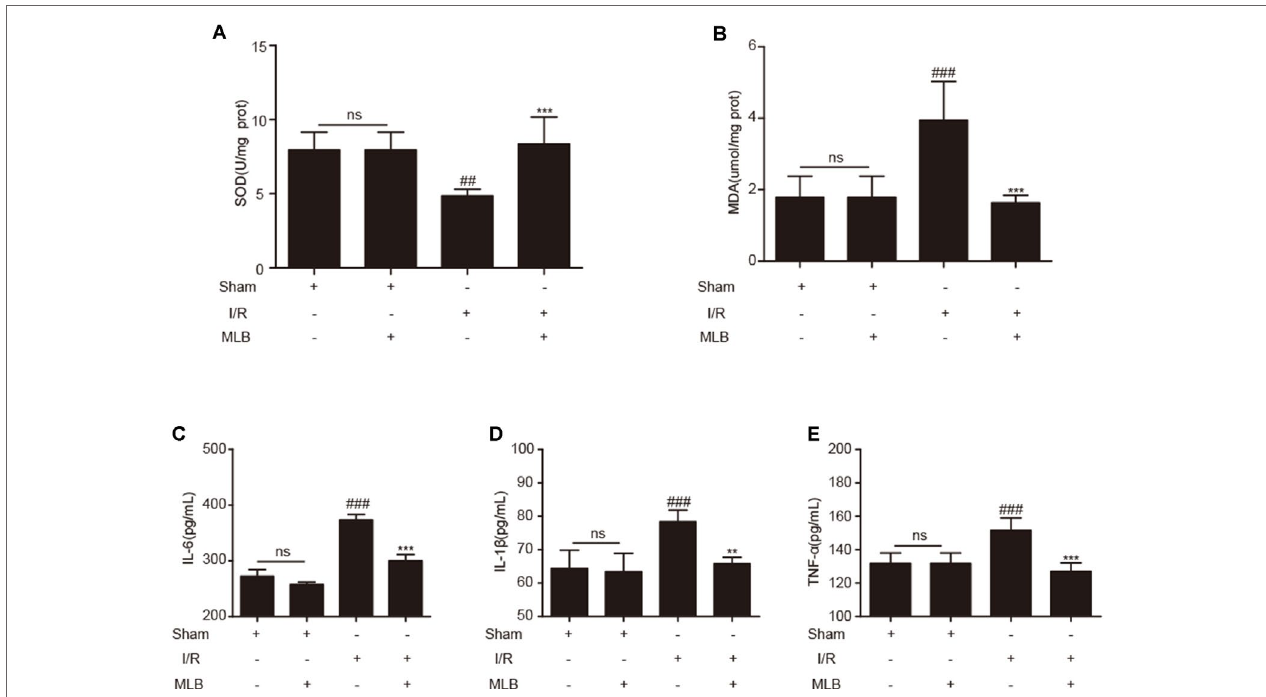
FIGURE 3 | MLB pretreatment affected oxidative stress in liver and inhibited inflammatory factors’ expression. (A , B) The levels of SOD and MDA in liver tissue of sham, I/R, and MLB pretreatment groups. (C – E) Serum IL-6, IL-1 β , and TNF- α were detected by ELISA in sham, I/R, and MLB group. The data are expressed as mean ± SD; ns: no statistical significance; ## P < 0.01, and ### P < 0.001 versus sham group; **P < 0.01, and ***P < 0.001 versus I/R group; n = 5 for each